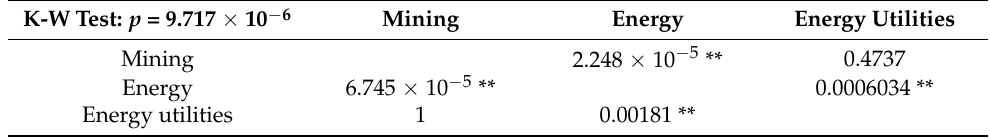
Table 2. Statistical significance of differences in total environmental grades, Bonferroni corrected \ incorrected.